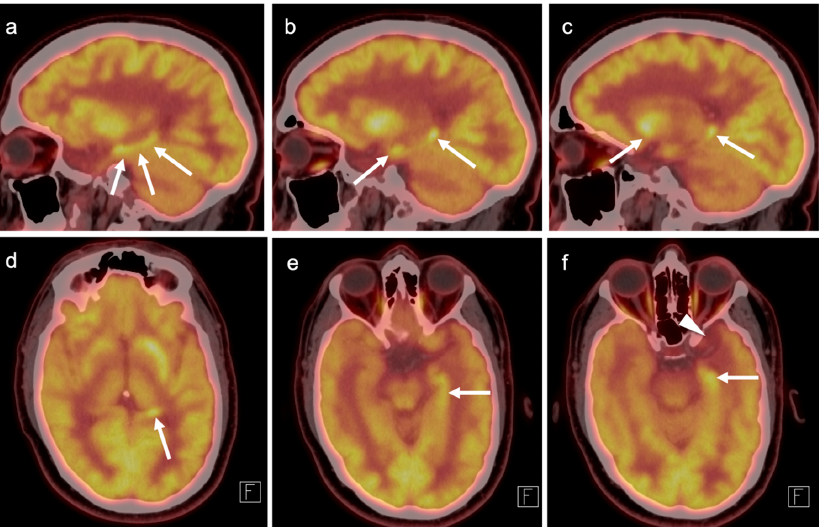
Figure 34. Limbic encephalitis. Patient presented with diplopia, dizziness, headaches, behavioral and memory disturbances. ( a – c ) Sagittal FDG PET ‐ CT images show increased metabolic throughout the entirety of the hippocampus (white arrows). ( d – f ) Axial FDG PET ‐ CT images show increased metabolic activity throughout the entire left hippocampus (white arrows). There is also decreased metabolic activity in the anterior left temporal lobe (white arrowhead). Limbic encephalitis can either be autoimmune or paraneoplastic in etiology. Cancers 2022 , 14 , x FOR PEER REVIEW